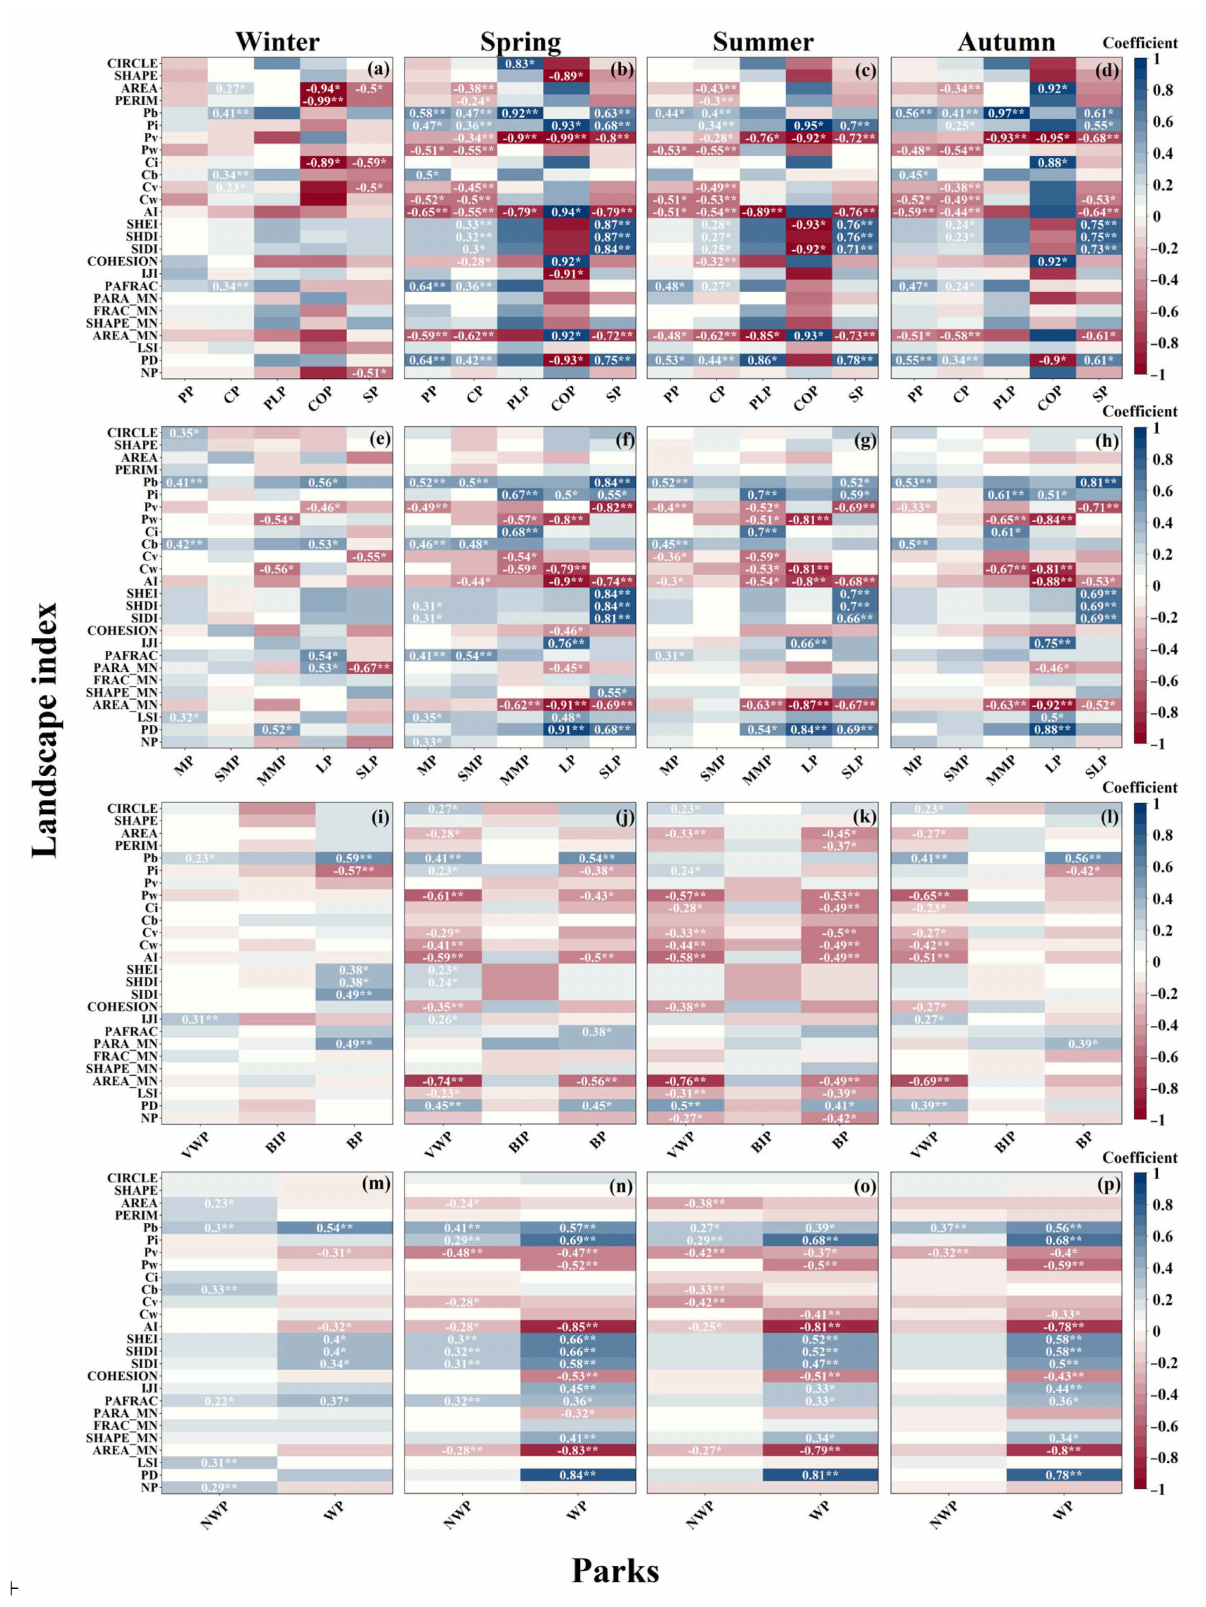
Figure 8. Heatmaps of correlation coefficients between landscape patterns and LST in different types of parks ( a – p ). The number of stars shows the significance level of the coefficient, ** p < 0.01, * p <